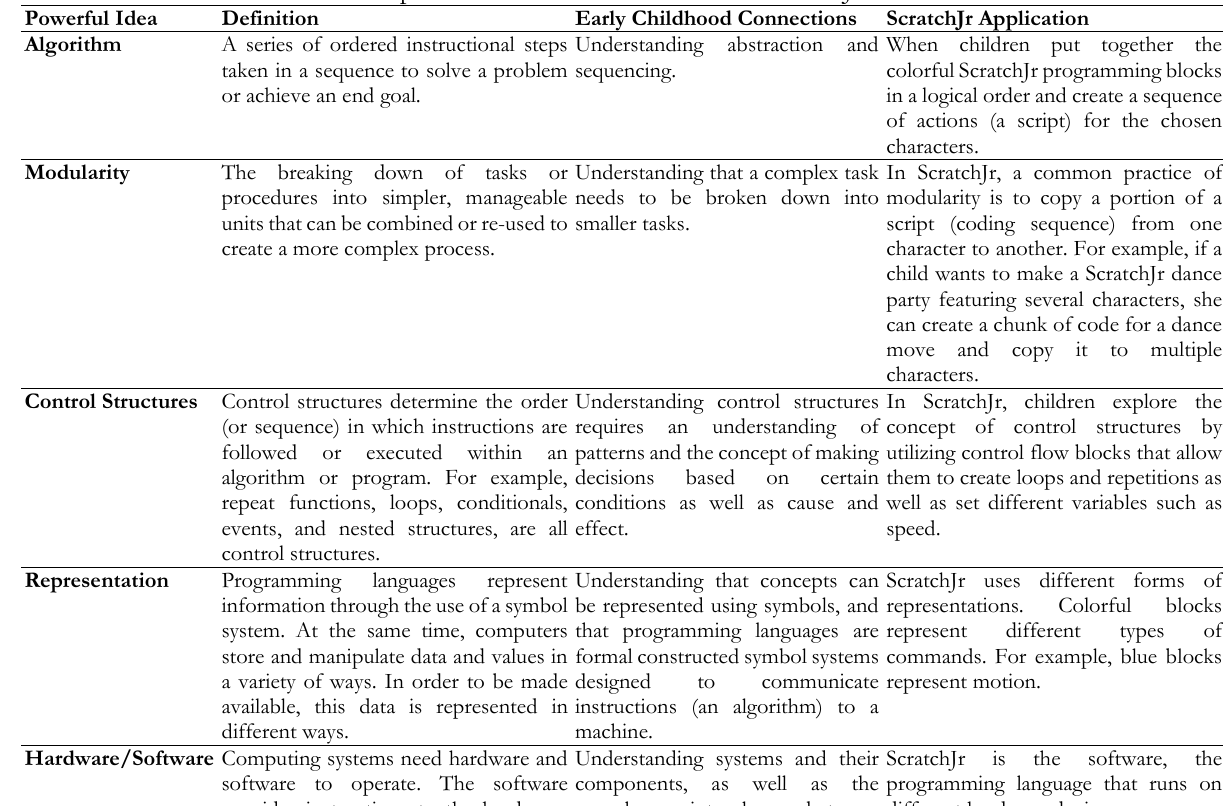
Table 1. Powerful Ideas from Computer Science and Connections to ScratchJr Powerful